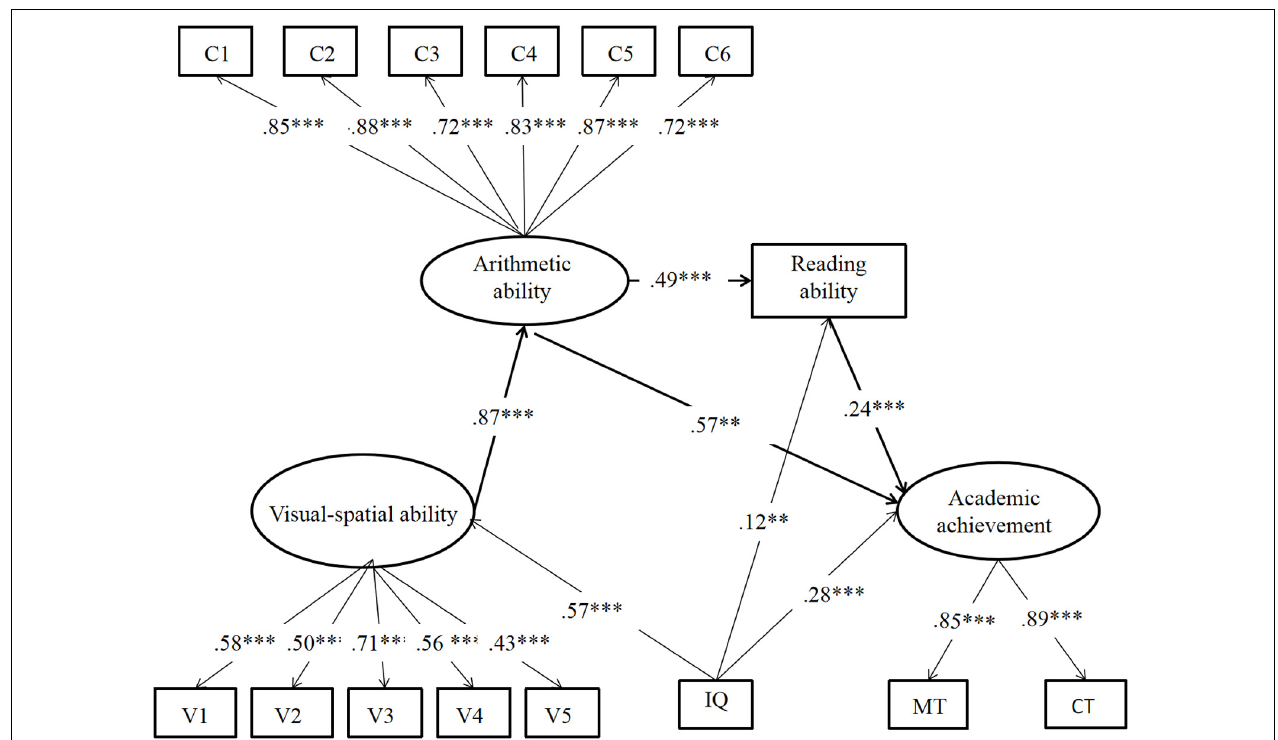
FIGURE 3 | Mediation effects of arithmetic and reading abilities between visual–spatial ability and academic achievement. V1–V5: number continuation; visual length; figure counting; square counting; number connection. C1–C6: addition; subtraction; multiplication; division; comparison; blank filling. MT: average scores on math curriculum test in the fifth and sixth; CT: average scores on Chinese curriculum test in the fifth and sixth. One-headed arrows represent significant paths; non-significant paths are not represented. ∗∗ p < 0.01, ∗∗∗ p <